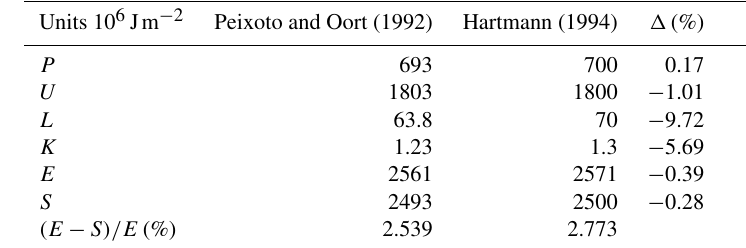
Table 2. Earth’s energy comparison.